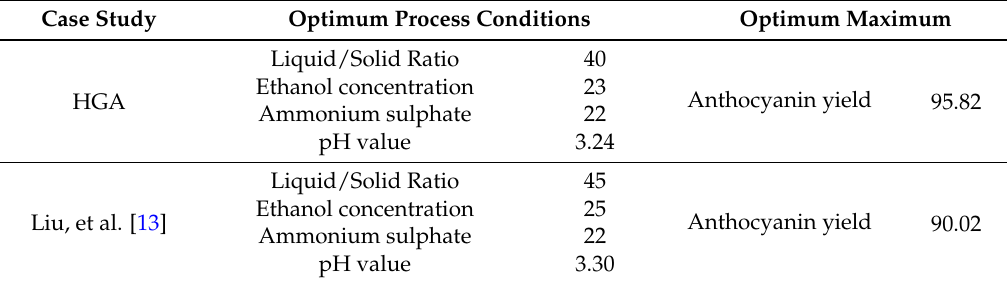
Table 7. Results for the case study on the anthocyanin yield.